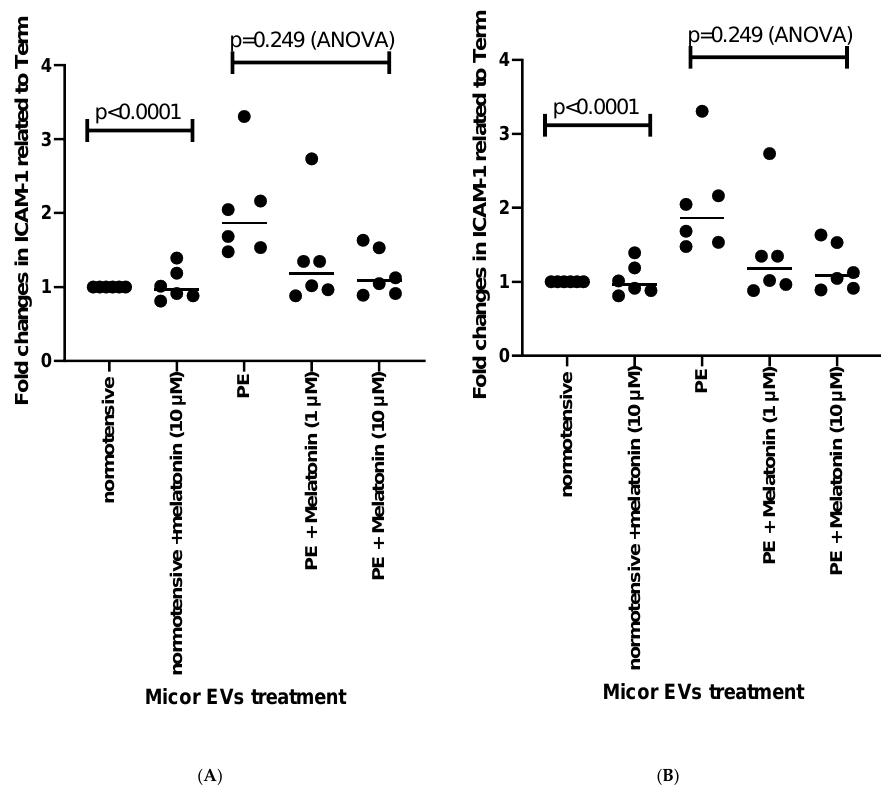
Figure 2. The activation of endothelial cells after being exposed to micro- ( A ) or nano-EVs ( B ) extruded from preeclamptic (PE) or normotensive placentae was measured by cell-surface ICAM-1 levels. The statistical analysis was assessed by an ANOVA test or a Mann–Whitney U-test, when appropriate. 10.3. Treatment with Melatonin Reduced the Levels of Misfolded Proteins in Preeclamptic Placentae and in Placental EVs from Preeclamptic Placentae There were significantly increased levels of misfolded proteins in micro- (Figure 3A, p = 0.0001) and nano-EVs (Figure 3B, p = 0.0001) collected from preeclamptic placentae compared to placental EVs collected from normotensive term placental explants, meas- ured by the fluorescent intensity of ThT (measured at 485 nm). However, this increased fluorescent intensity of ThT was significantly reduced when placental EVs were collected from melatonin-treated (1 or 10 µM) preeclamptic placental explant cultures (Figure 3A,B, p = 0.0001, ANOVA). There was no dose response in the reduction of the fluorescent intensity of ThT.